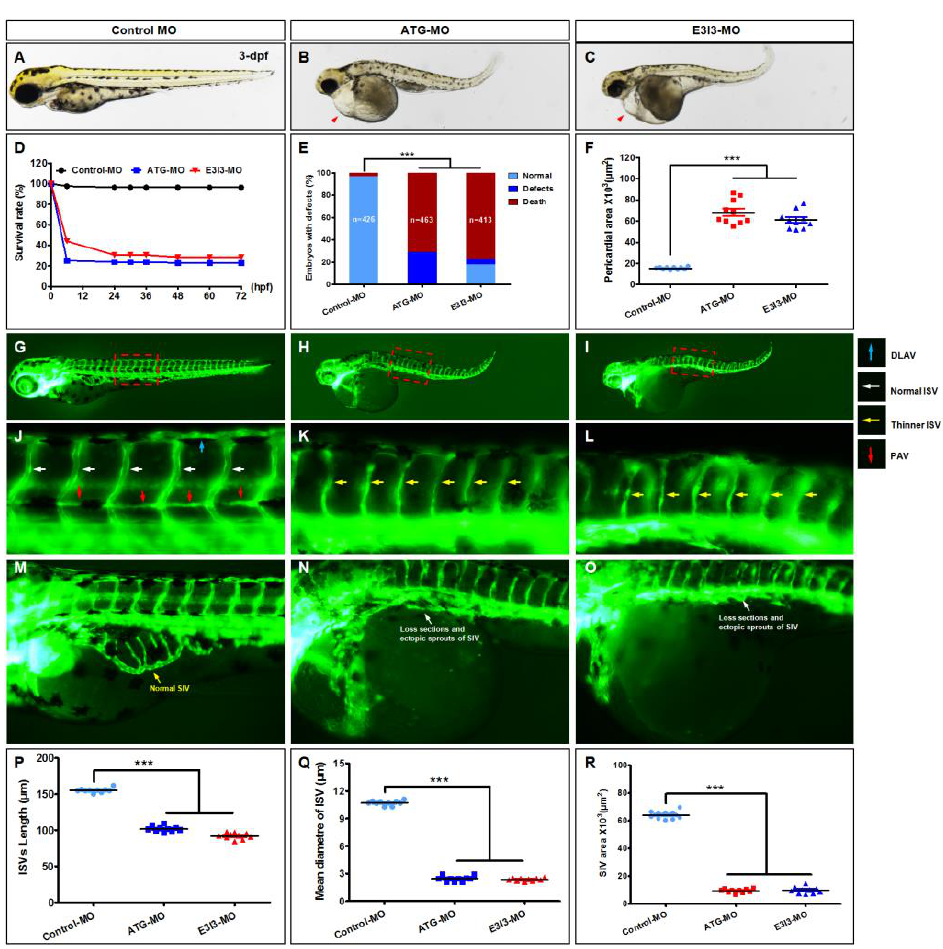
Figure 5. Loss of eif1axb phenocopies FA-induced cardiovascular defects. ( A – C ) Gross morphology of zebrafish embryos at 3 dpf. Compared with control zebrafish, eif1axb knockdown causes pericardial oedema (( B , C ), red arrowheads), reduced contractile force, and reduced precardial blood congestion as signs of manifest heart failure. ( D ) A time–course plot of percent survival in control vs. eif1axb morphants for 3 days. Panel ( E ) shows the percentage of embryos with developmental defects. ( F ) Quantification of the pericardial area of embryos. Error bars: means ± SEM. *** p < 0.001 ( n = 10; ANOVA.). ( G – O ) Representative fluorescent images of Tg(fli1a:EGFP) y1 embryos at 3 dpf. ( G , J ) Images of trunk regions taken at 3 dpf, with the vascular structures visualized by eGFP fluorescence and labeled ISV and DLAV, showed regular development in the embryo injected with control MO. Compared with control MO, embryos injected with eif1axb -MO presented thinner ISVs (( K , L ), yellow arrows). In control embryos, the parachordal vessels (PAVs) formed normally (( J ), red arrows). Compared with control, MO knockdown eif1axb prevented PAV formation, the precursor to the lymphatic system ( K , L ). The boxed regions are shown at higher magnification in the bottom panels. In control embryos, SIV vessels developed as a smooth, basket-like structure over the yolk at 3 dpf (( A , E ), yellow arrow). In contrast, embryos injected with eif1axb -MO presented a decreased number of ectopic SIV segments (( M ), asterisks). ( P , Q ) Quantification of the mean length and diameter of ISVs showed a significant decrease in eif1axb morphants. Columns: mean ± SEM ( n = 10; ANOVA; *** p < 0.001). ( R ) Quantification of the area of SIVs showed a significant decrease in eif1axb morphants. Columns: mean; bars: SEM ( n = 10; ANOVA; *** p < 0.001). DLAV: dorsal longitudinal anastomotic vessels; ISV: intersegmental vessel; dpf: days postfertilization.